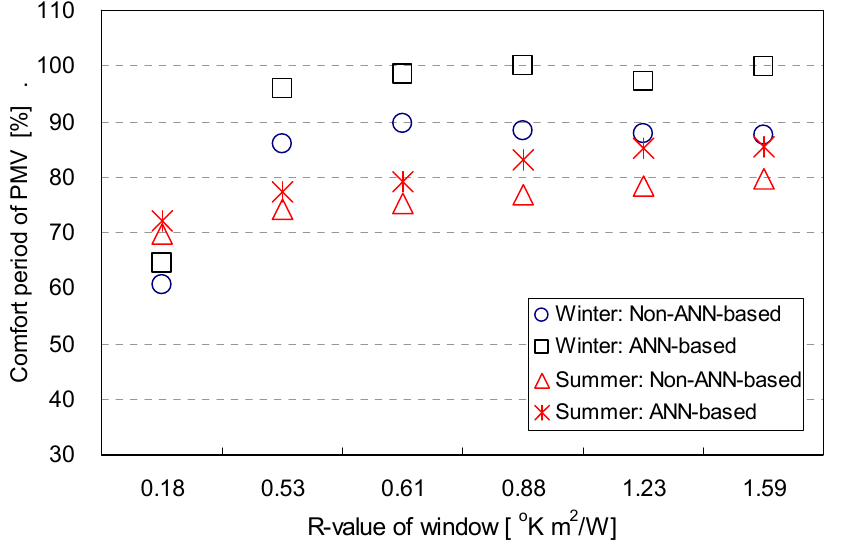
Figure 11. PMV comfort periods based on R -values of windows.